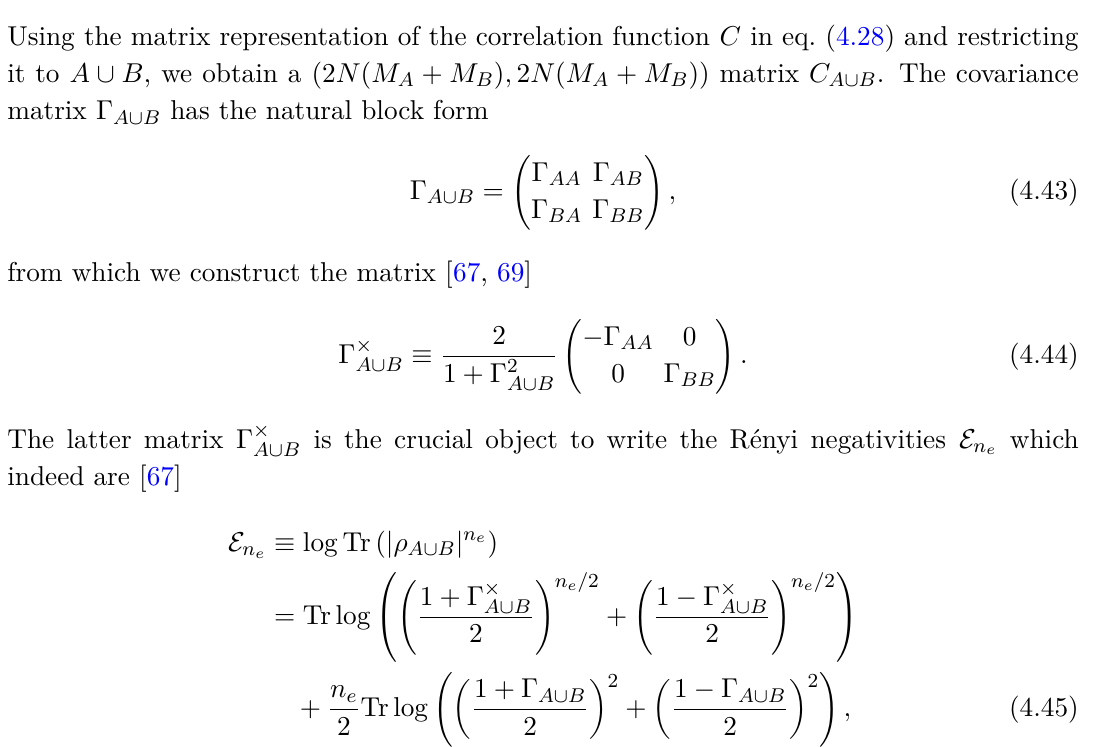
are fitted using the i